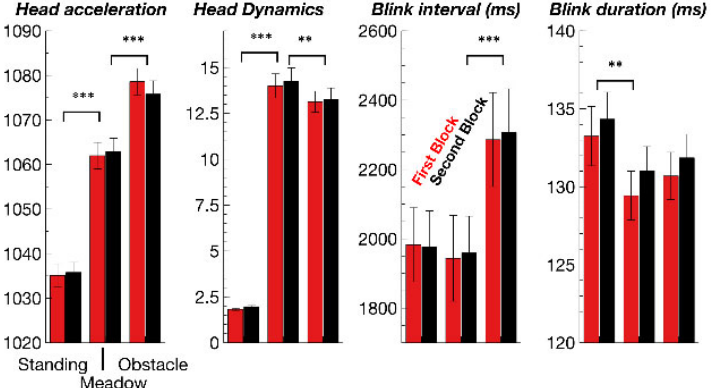
Figure 3. Behavioral data (mean and standard error of mean) obtained in the three walking conditions, separately, for block 1 (red) and block 2 (black). Head acceleration steadily increased with walking complexity. Head dynamics were largest when walking on meadow. When crossing the obstacle course, head dynamics were reduced, possibly due to head stabilization for fixations. Blink intervals increased on the obstacle course; on the other hand, blink duration increased while standing. Significant effects of walking condition are depicted for all pairwise comparisons (***: p < 0.001; **: p < 0.01).